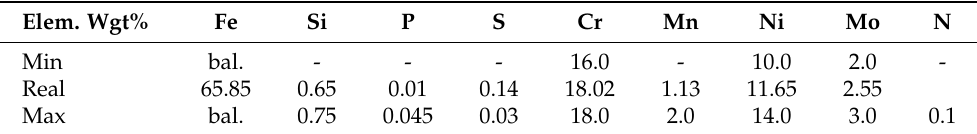
Table 1. Chemical composition of the 316L stainless steel (weight percent). Elem. Wgt%